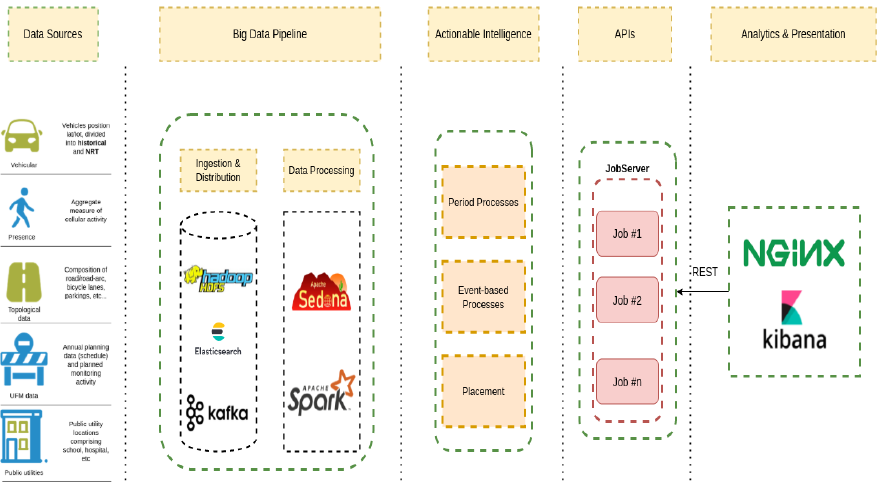
Figure 2. Technological components of the IPPODAMO